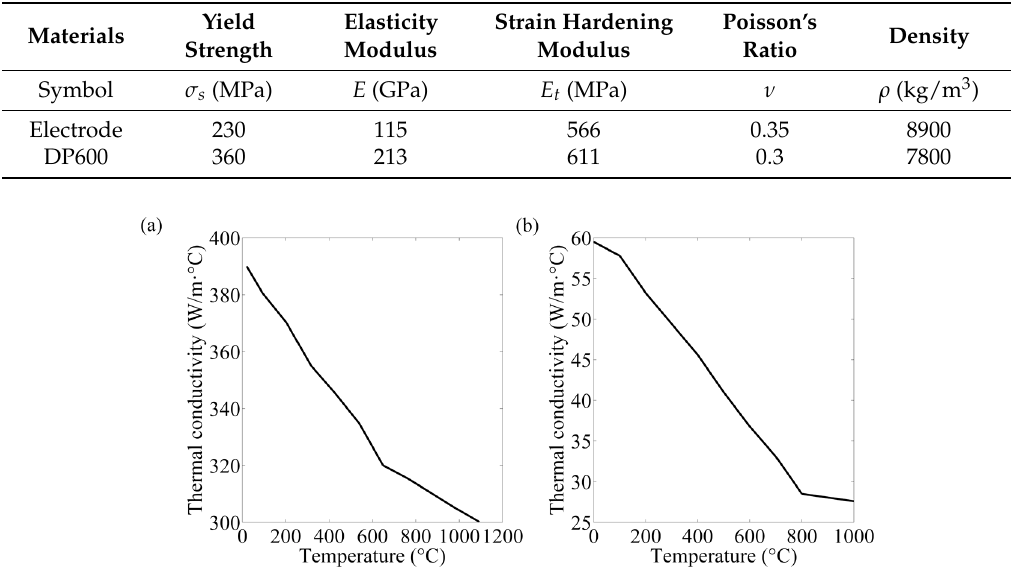
Figure 4. Thermal conductivity of the electrode ( a ) and DP600 ( b ).